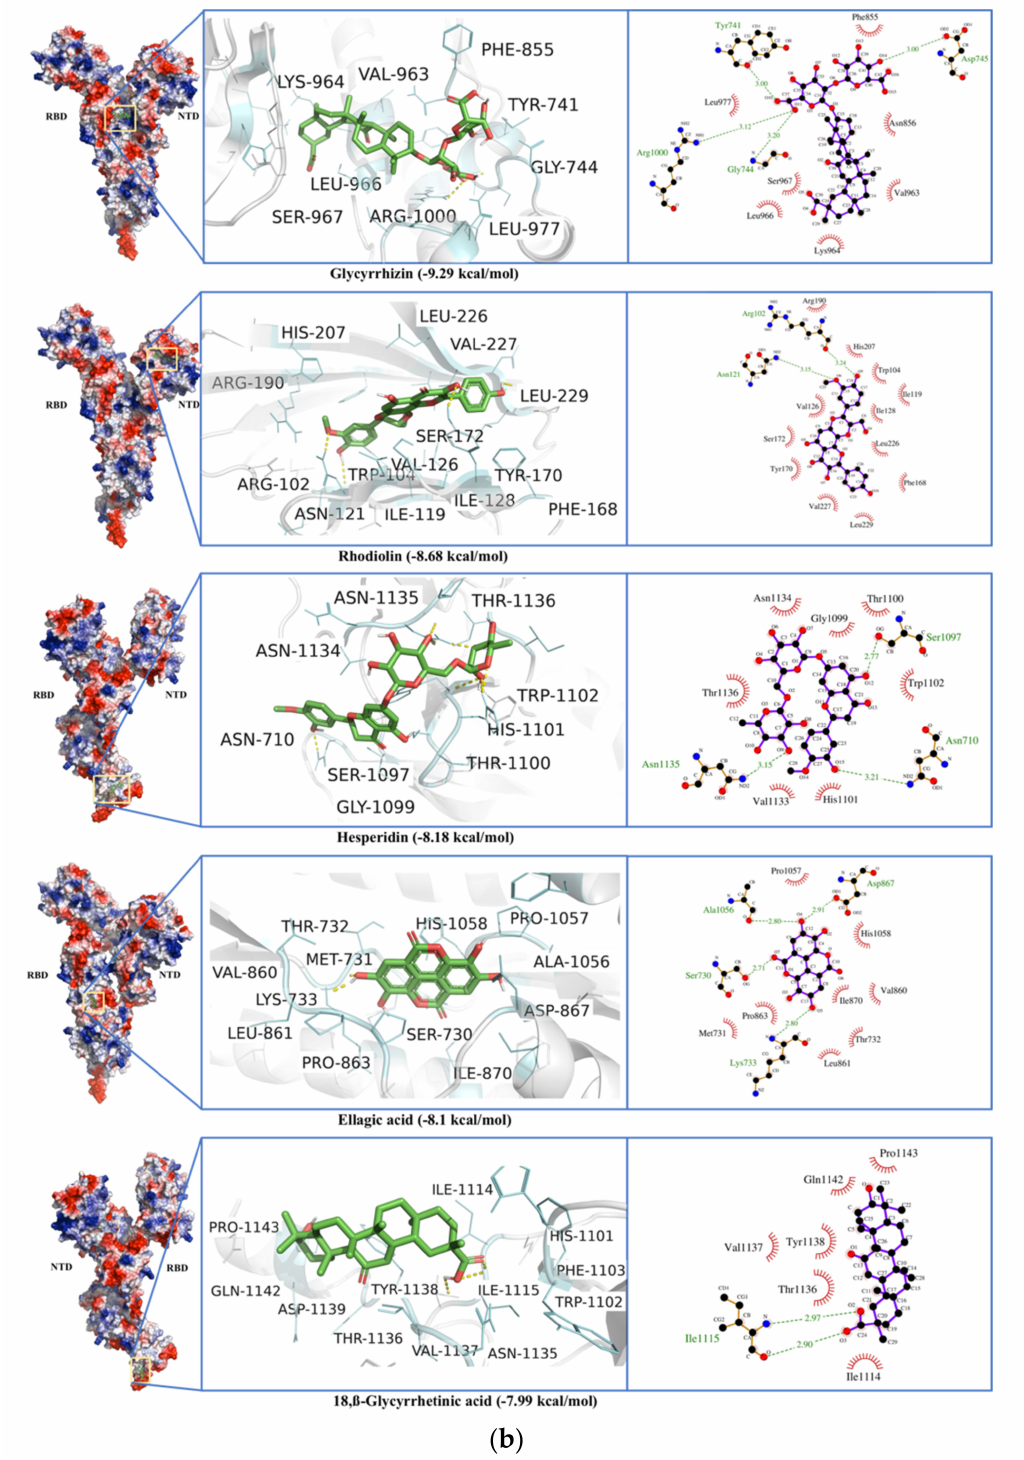
Figure 8. ( a ) Glycyrrhizin, Rhodiolin, Hesperidin, Ellagic acid, and 18, β -Glycyrrhetinic Acid docking to open state of the spike protein of SARS-CoV-2 Spike protein (S). ( b ) Glycyrrhizin, Hesperidin, Umbelliprenin, 18, β -Glycyrrhetinic Acid, and Silyhermin docking to the closed state of the spike protein of SARS-CoV-2 Spike protein